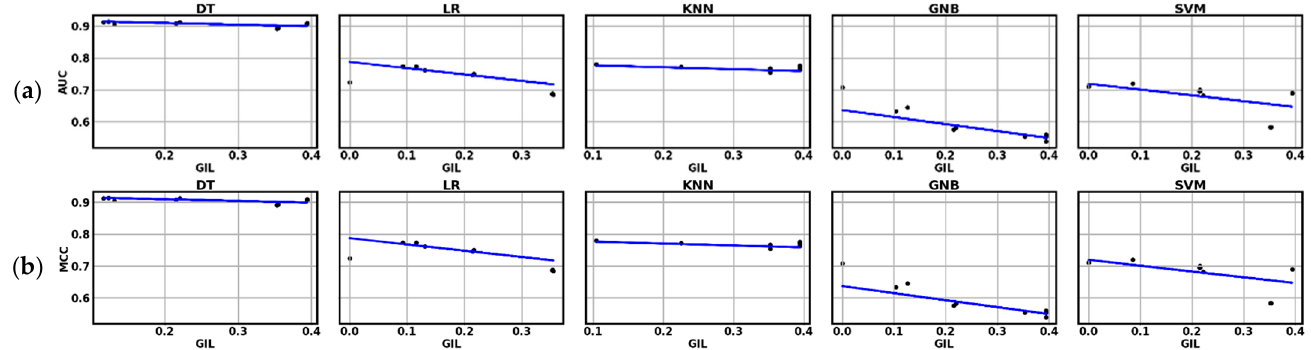
Figure 2. The prediction results of the tested machine learning models demonstrated with the AUC and MCC metrics, in juxtaposition with the GIL value. ( a ) The results of the logistic regression (LR), decision tree (DT), Gaussian naïve Bayes (GNB), k-nearest neighbors (KNN) and support vector machine (SVC) classifiers, plotted against k , for each qi value. ( b ) The results of the same models plotted against qi for each k value.